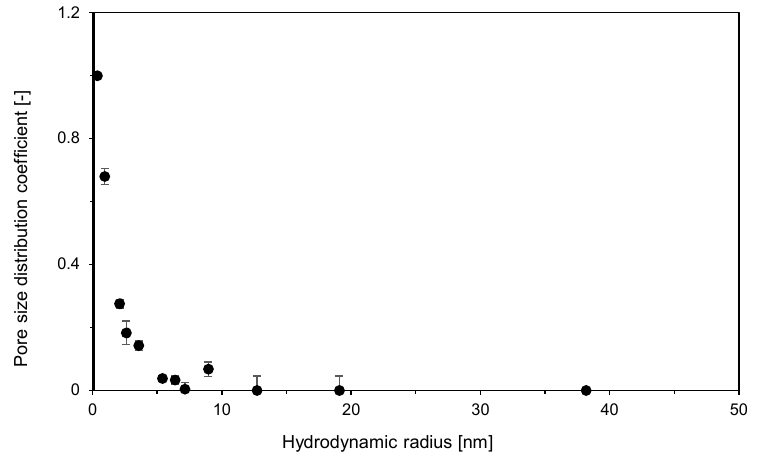
Figure 2. Secondary pore-size distribution coefficient vs. solute hydrodynamic radius for Sartobind STIC membranes obtained by inverse size-exclusion chromatography. The experiments were performed in triplicate, error bars represent standard deviations.